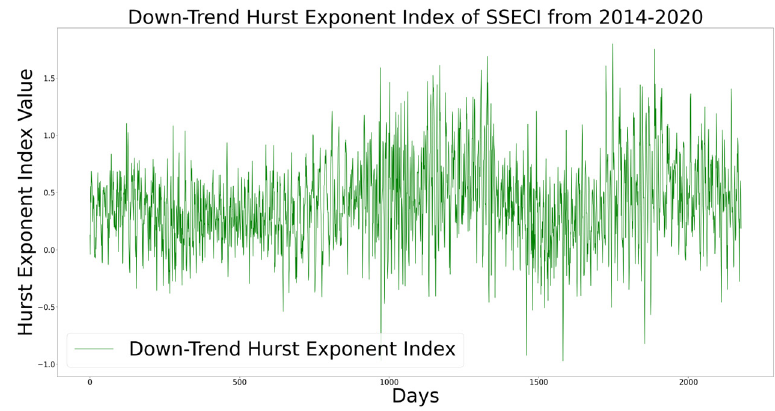
Figure 6. The graph of down ‐ trend Hurst exponent index of SSECI.